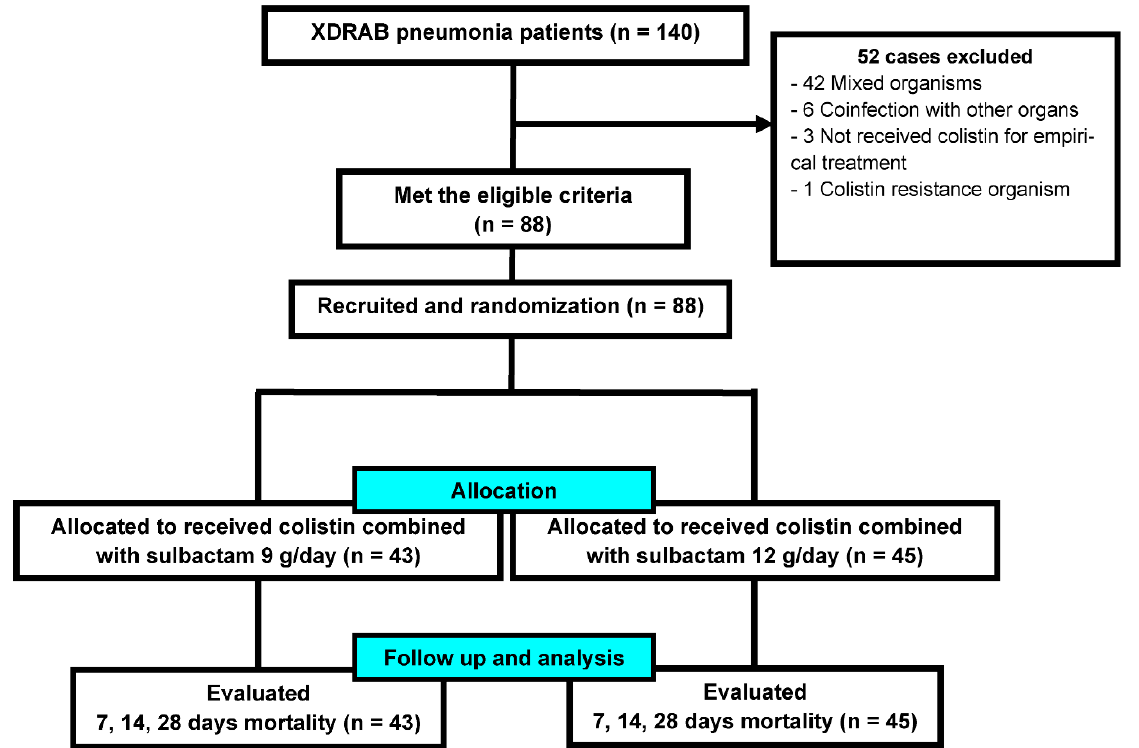
Figure 1. Enrollment and follow - up of the participants. Table 1. Baseline characteristics.